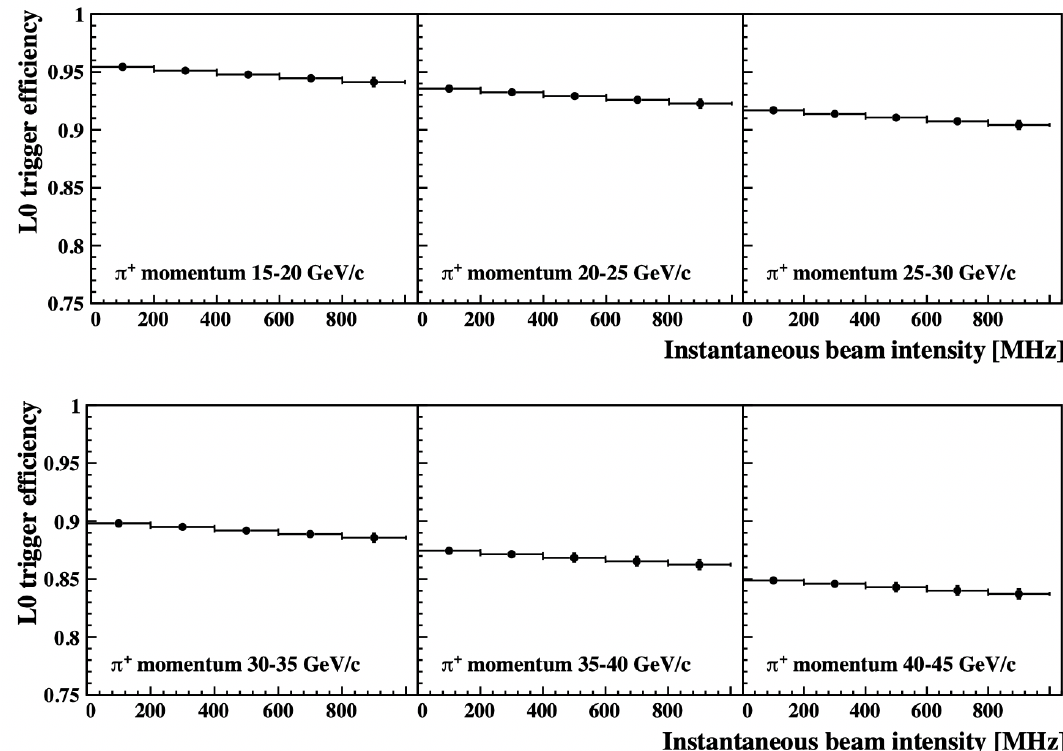
Figure 5. Efficiency of the PNN L0 trigger conditions as a function of the instantaneous beam intensity in bins of π + momentum.